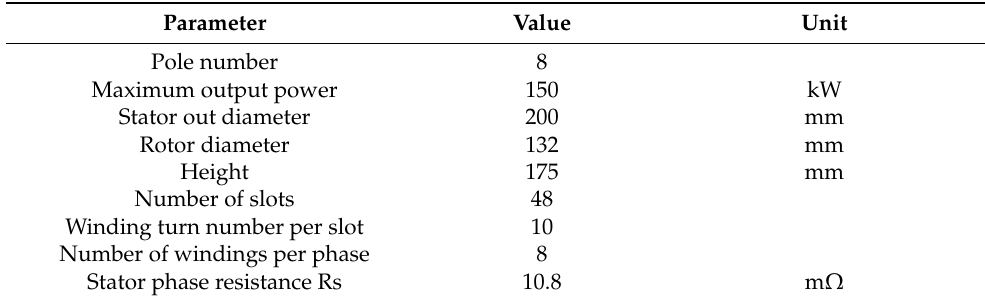
Figure 4. ( a ) Cross-sectional view of the PMSM and ( b ) the conductors in a slot of the reference motor ( left ) and tap-change motor ( right ). Table 1. Reference motor